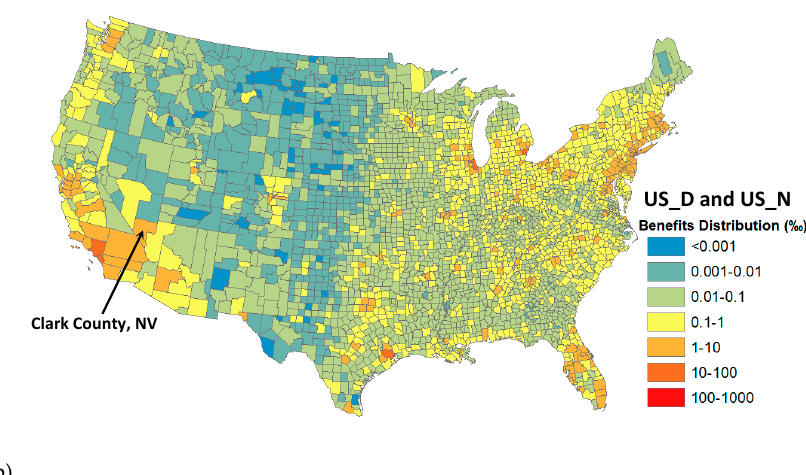
Figure 3. Distribution of health benefits (in ‰ ) from reducing transit bus emissions ( a ) in Clark County, Nevada and ( b ) all over the US, based on the COBRA modeling for (a) CC_D and CC_N and ( b ) US_D and US_N scenarios. All CC (or US) scenarios yield consistent spatial distributions (see Supplementary Materials Tables S8 and S9 for data).